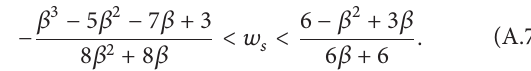
Table 7: Equilibrium outcome under AMR scenario with assort- ment F.